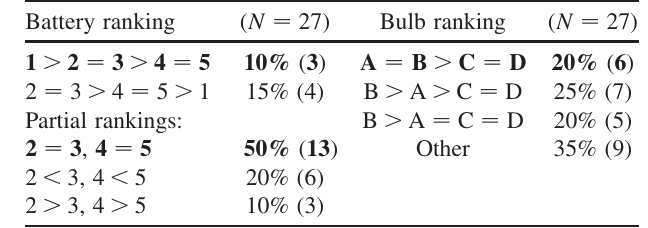
TABLE II. Common rankings for multiple batteries in parallel pretest question of Fig. 3. In all tables, bold font indicates correct answers.